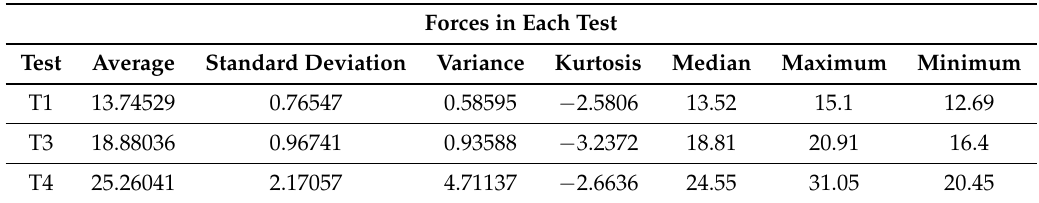
Table 5. Test made for the experiment with 221 events.